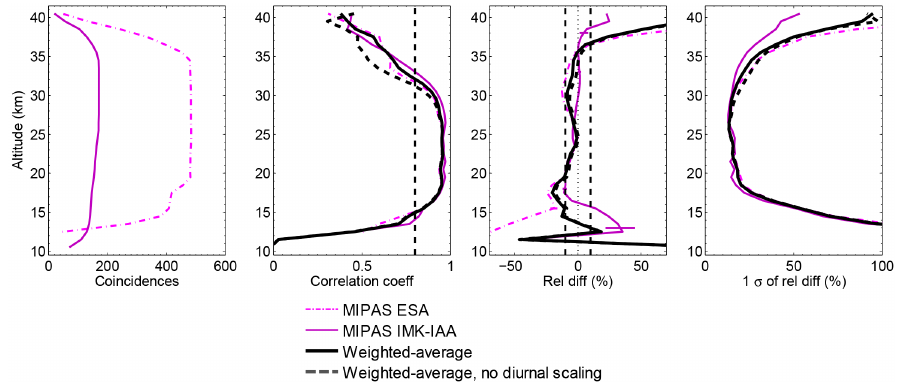
Figure 17. Comparisons between ACE-FTS and MIPAS ClONO 2 measurements with coincidence criteria of within 4h and 100km. Error bars in the relative difference profiles represent the standard error of the mean.